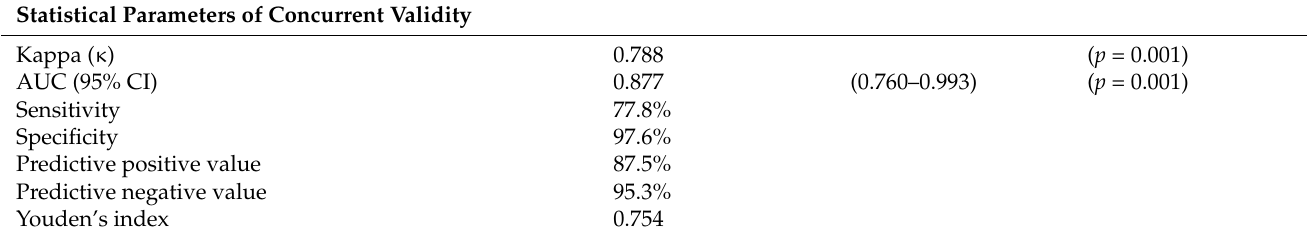
Table 5. Concurrent validity of GLIM criteria, using the SGA as reference.